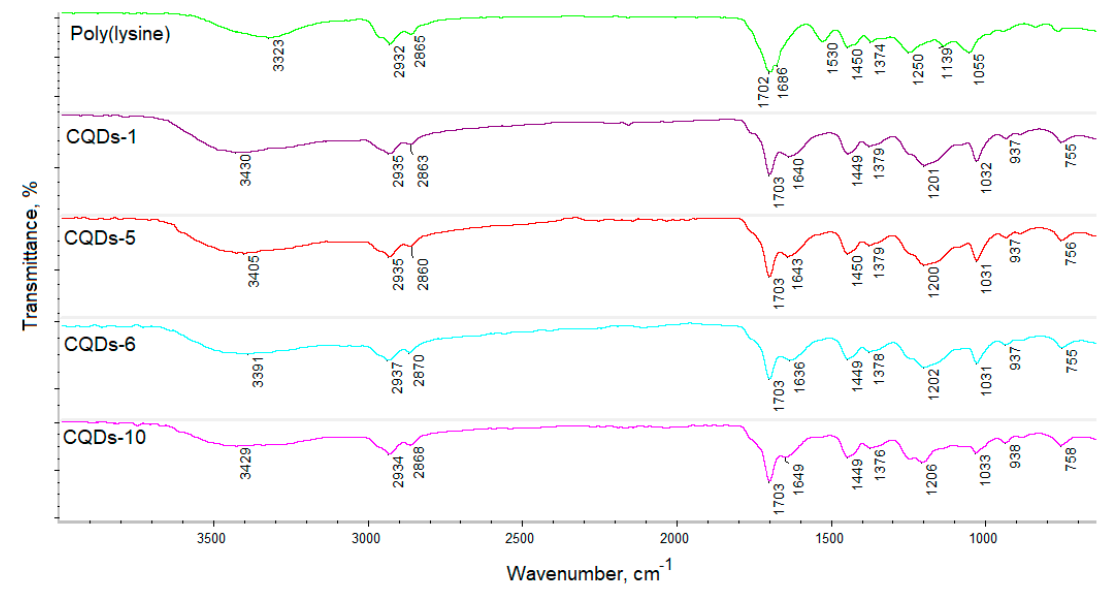
Figure 1. FT-IR spectra of the prepared CQDs.